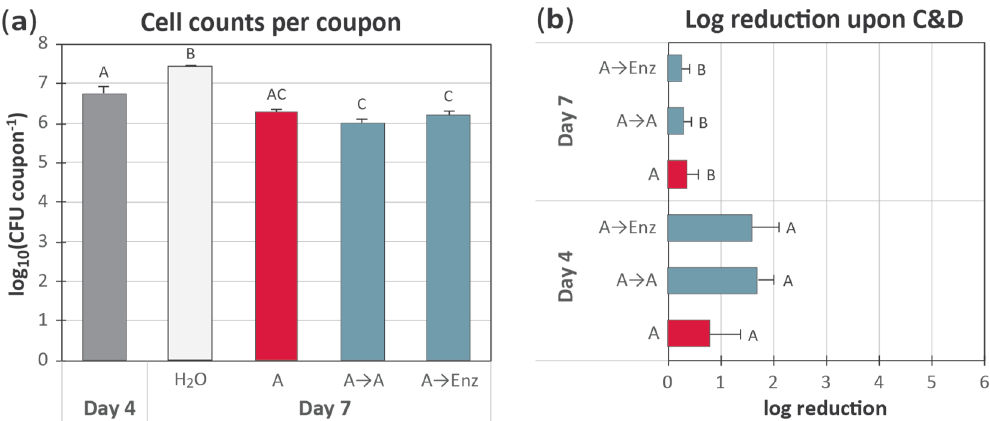
Figure 3. The four-day-old biofilms were subjected to C&D treatments on days 4, 5, 6, and they were allowed 24 h of regrowth before sampling. The C&D treatments were either (i) 2% Agent A for 10 min only (A); (ii) 2% Agent A for 10 min followed by 2% Agent A at 45 °C for 30 min at RT (A → A); or (iii) 2% Agent A for 10 min followed by an Enzymatic Agent pre-heated to 45 °C, for 30 min at RT (A → Enz). After these treatments, all coupons were disinfected with 1.5% PAA. ( a ) Counts of L. monocytogenes in conveyor belt biofilms prior to C&D at day 4 and day 7. ( b ) Tolerance of biofilms to treatment regimes. Results are based on three replicates; details are otherwise as described in the legend to Figure 2.